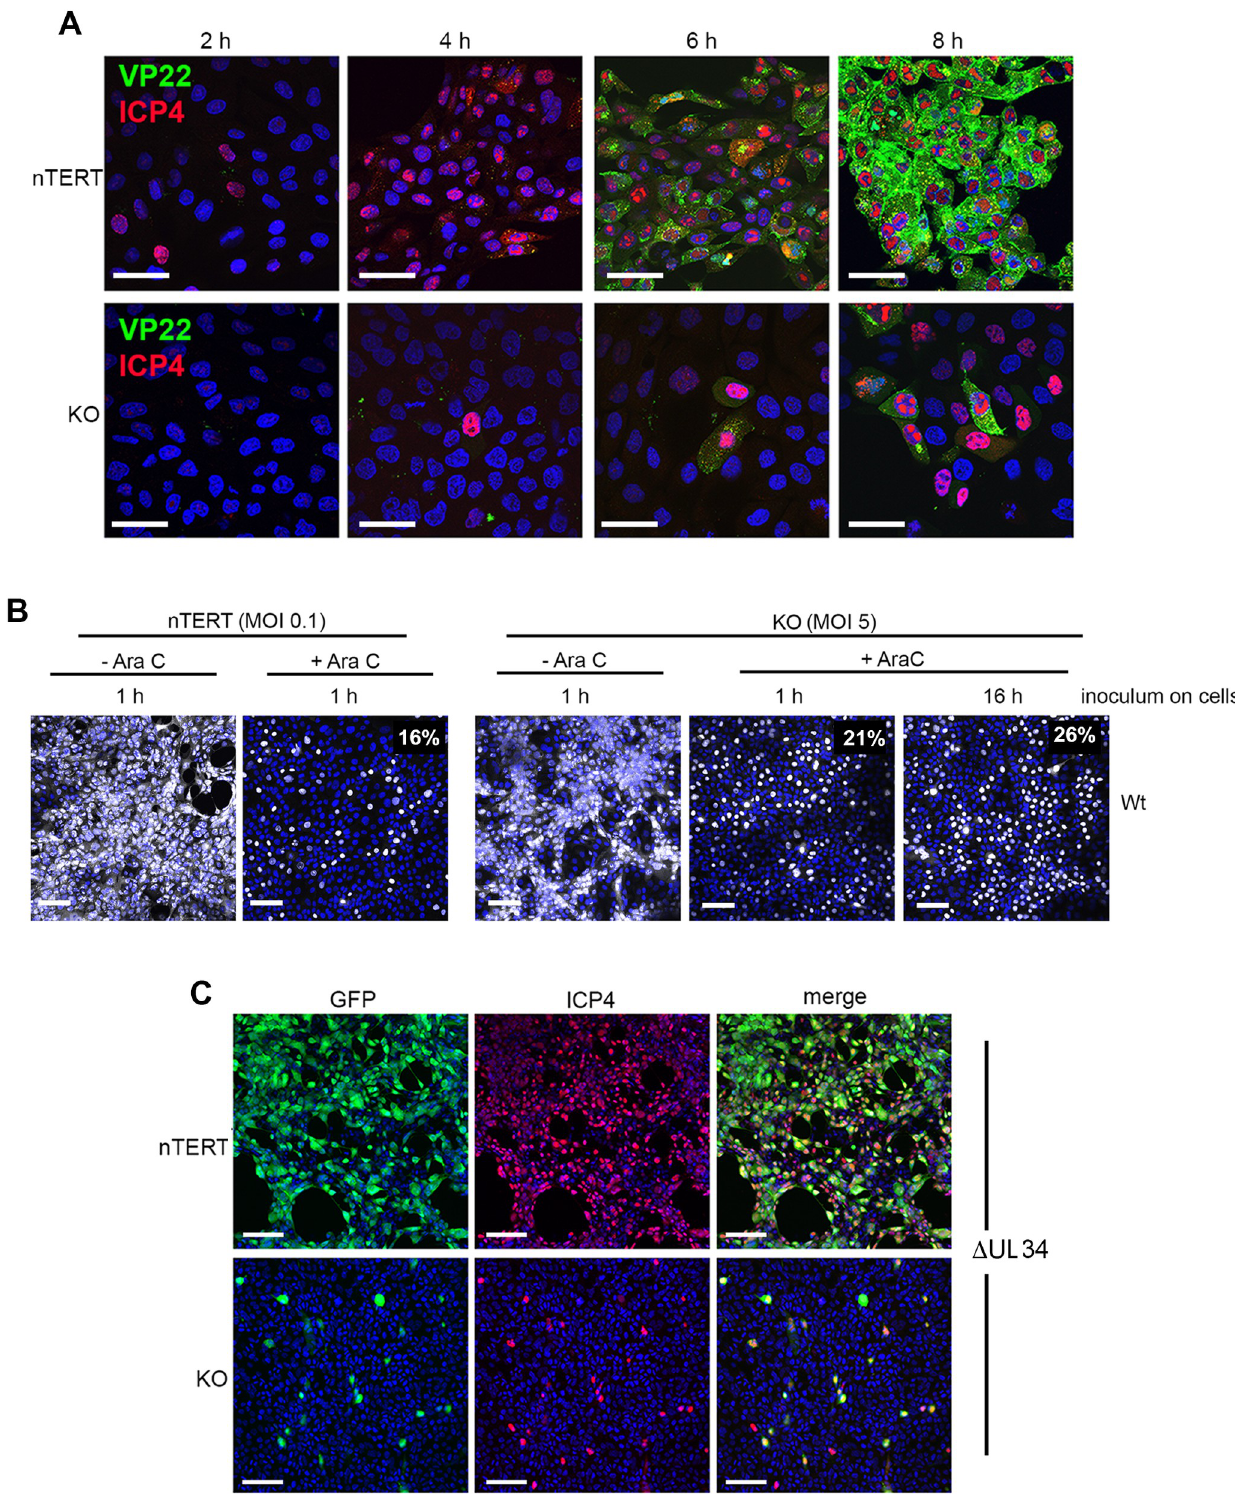
Fig 4. HSV1 exhibits delayed infection in majority of nectin1 KO cells. (A) nTERT and KO cells grown on coverslips were infected with HSV1 GFP22 (green) at MOI 5 and fixed at the indicated times. Cells were permeabilised and stained for ICP4 (red) and nuclei were stained with DAPI (blue). Scale bar = 50 μ m. (B) nTERT and KO cells were infected with HSV1 Sc16 at MOI 0.1 or 5 respectively (as determined in Vero cells) in the absence or presence